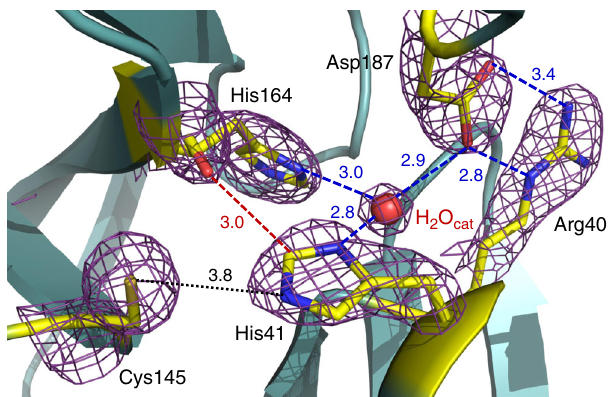
Fig. 2 The catalytic site of 3CL M pro from SARS-CoV-2. Hydrogen bonds are shown as blue dashed lines; the distance between Cys145 and His41 is shown as a black dotted line, the dashed red line indicates a strong C – H … O bond. The 2F O – F C electron density map contoured at 1.6 σ level is shown as a violet mesh. All distances are given